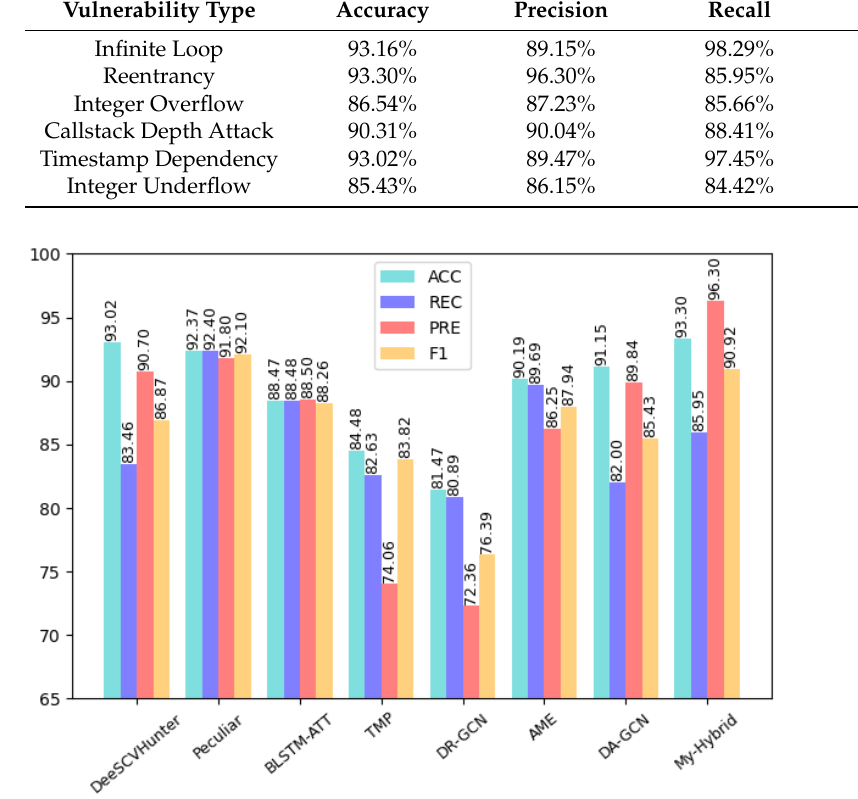
Figure 12. Reentry vulnerability detection results.